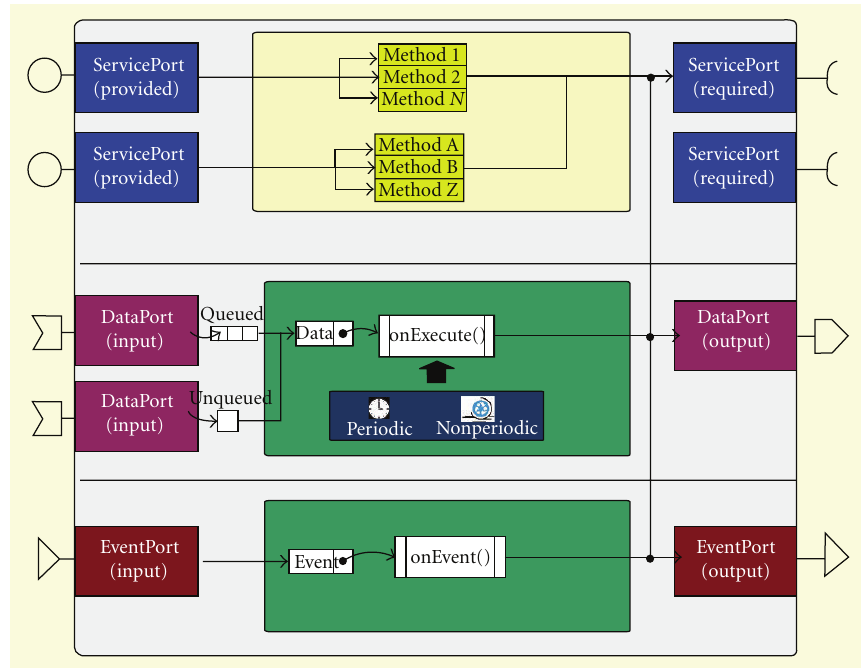
Figure 9: OPRoS component model (© (2010) ETRI) (reproduced from [47] with permission of ETRI